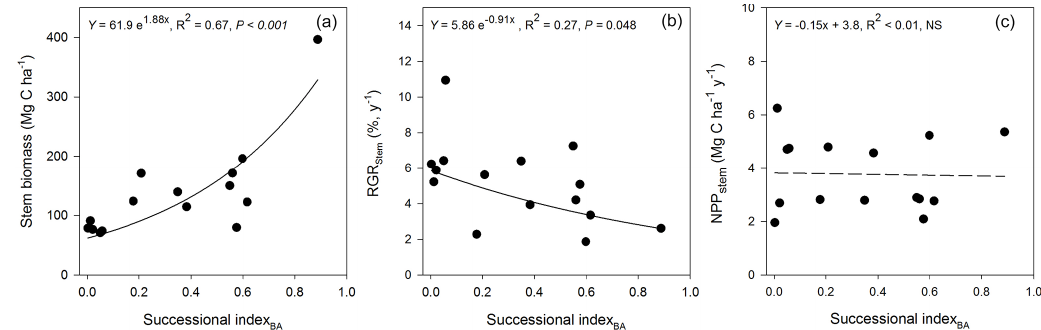
Figure 5. Biomass (a) , relative growth rates (RGR) ( b ) and net primary production (NPP) ( c ) of stems including branches of each plot in relation to its successional index, based on basal area (BA) of most abundant early and late successional tree species (Eq. 10). Biomass, RGR and NPP are based on C units and calculated from Eqs. (3), (6), (5), respectively, based on measurements of D BH , height, wood density and a stem tissue C concentration of 47.4%. The adjusted R 2 values are 0.65 and 0.21 in (a, b) . Table 5. Net primary production (NPP, Eq. 5) of different forest compartments (means ± SD and range) for all plots (1–15) classified as early (ES, n = 5) and late (LS, n = 5) successional. Diff and P value represent the mean differences and the results of t test of the difference between ES and LS, respectively. For C concentrations of different compartments see Table 4. NPP values are in MgCha − 1 year − 1 . OL, organic soil layer; ML, mineral soil layer. All plots (1–15) Plots of different successional